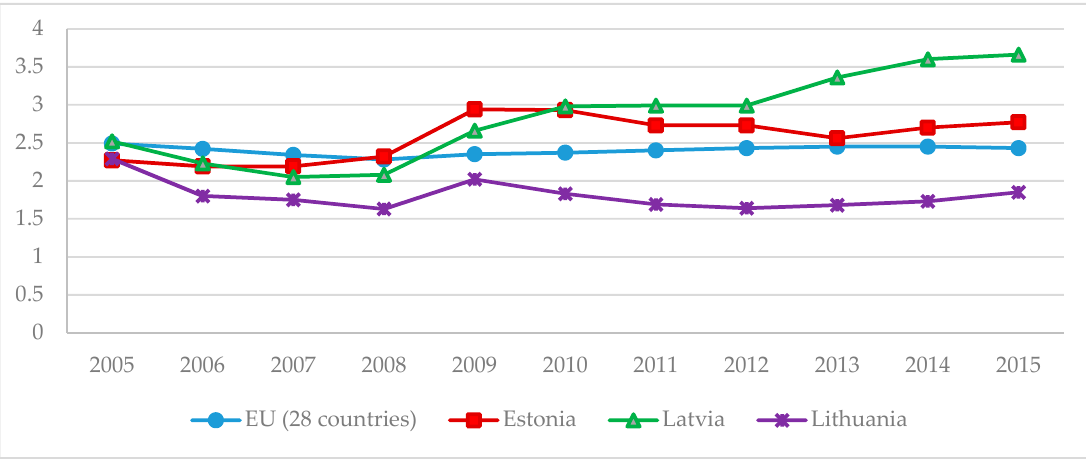
Figure 2. Revenues from environmental taxes in the Baltic States, as the percentage of gross domestic product (GDP). EU: European Union.